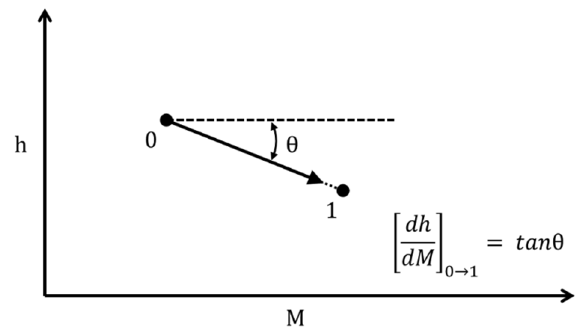
Figure 4. Condition to achieve a transition from state (0) to state (1) in the h-M plane